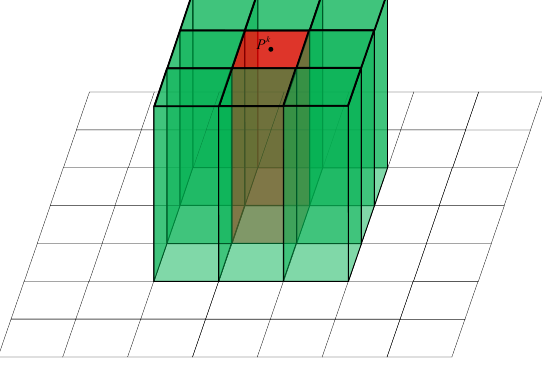
Figure 3. A square patch. The squares represent cells in the raster. The height of the vertical column represents the elevation values of each cell. The column in red represents a seed